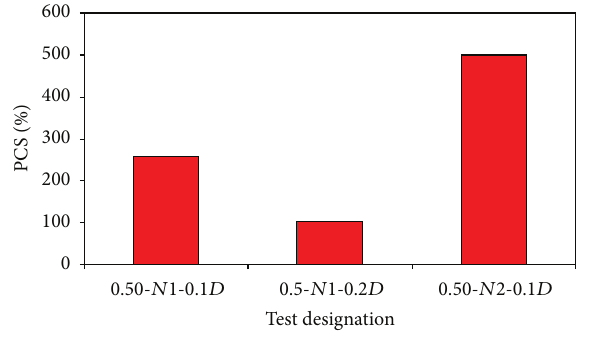
Figure 14: Percentage of Control in Settlement (PCS) for Series III ( 𝐷 = 0.50 𝑀 ).